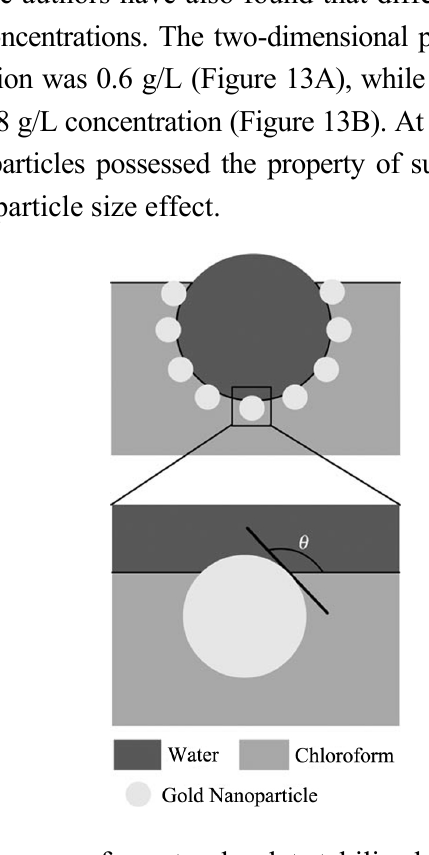
Figure 12. Schematic diagram of a water droplet stabilized by the dodecanethiol-stabilized gold nanoparticles at the water/chloroform interface, with copyright permission from [98]. Here, θ is the contact angle of a particle at the water/chloroform interface.